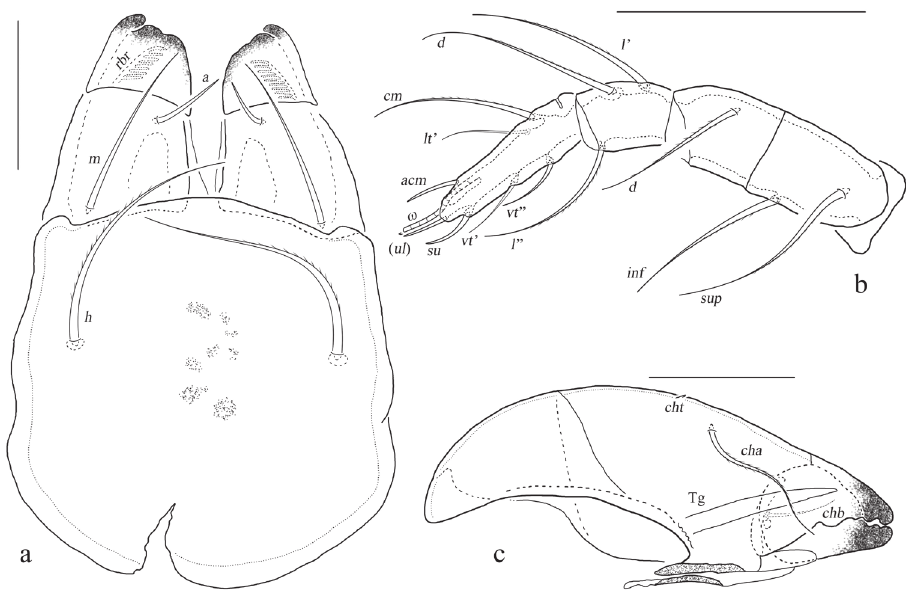
Figure 13. Eurostocepheus (Eurostocepheus) mahunkai Mondal & Kundu, 1999, adult: a subcapitulum, ventral view b left palp, abaxial view c left chelicera, adaxial view. Scale bars: 50